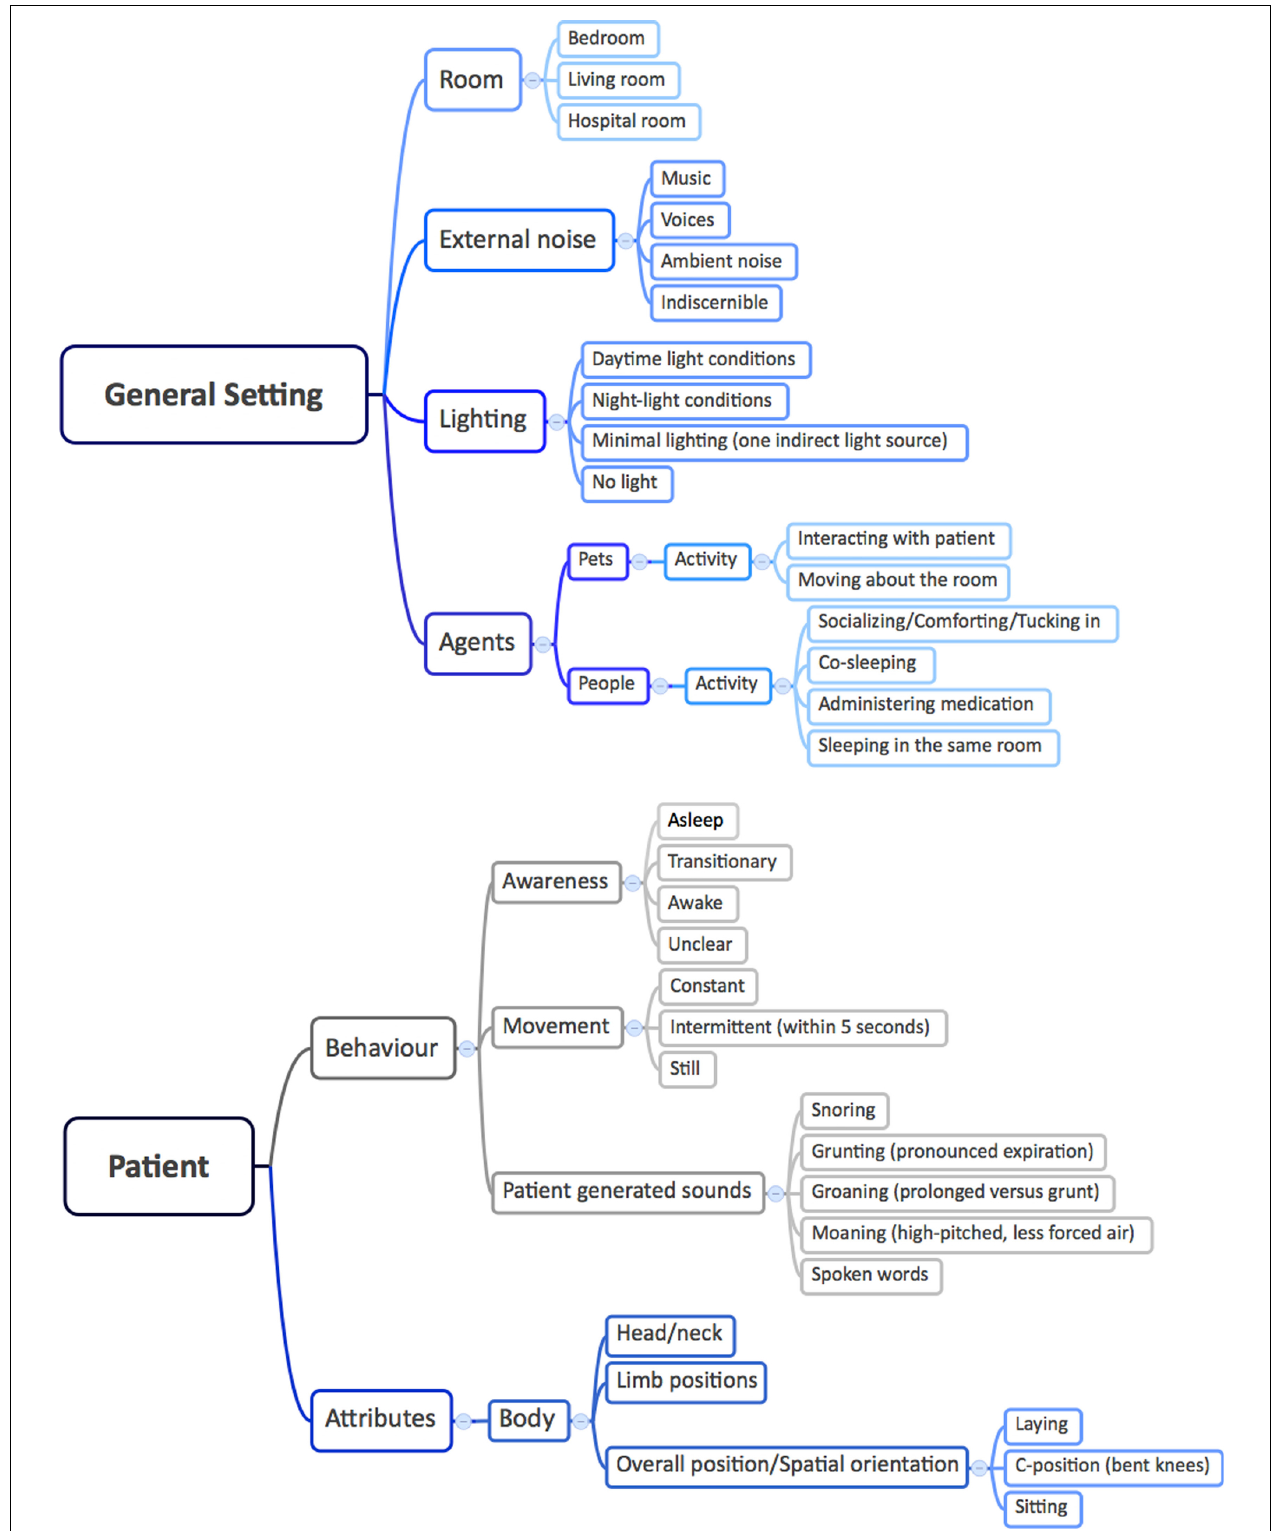
environment is categorized by the external factors that can influence sleep; the patient’s actions are categorized by types of sleep/wake behaviors and sleep